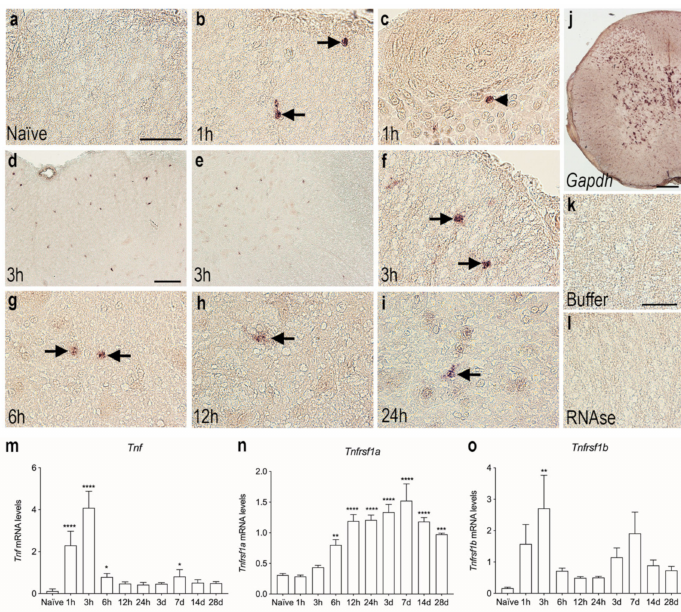
Figure 2. Cellular and temporal expression of Tnf mRNA in the thoracic spinal cord after SCI. ( a – i ) In situ hybridization was used to investigate the distribution of Tnf mRNA + cells the first 24 h after SCI. Tnf mRNA expression was undetectable in naïve mice ( a ). Tnf mRNA + cells in the white matter of the posterior funiculi (arrows in b ) and in neuronal-like cells in the dorsal horn (arrowhead in c ), at 1 h after SCI. Tnf mRNA + cells in the white matter of the posterior funiculi ( d ) and in the grey matter of the ventral horn ( e ). At 3 h, most cells displayed macrophage- or glial-like morphology (arrows in f ). By 6 h ( g ), 12 h ( h ), and 24 h ( i ), Tnf mRNA + cells were mainly located in white matter areas of the damaged spinal cord (arrows). ( j ) Parallel spinal cord sections that were in situ hybridized for glyceraldehyde-3-phosphate dehydrogenase ( Gapdh ) mRNA showed a largely neuronal signal and confirmed the overall suitability of the tissue for in situ hybridization. ( k , l ) Parallel sections hybridized with buffer alone ( k ) or pretreated with RNAse A before the in situ hybridization ( l ) were devoid of signal. ( m – o ) RT-qPCR analysis of Tnf mRNA ( m ) , Tnfrsf1a mRNA ( n ), and Tnfrsf1b mRNA ( o ) levels in naïve mice and in mice allowed 1, 3, 6, and 12 h and 1, 3, 7, 14, and 28-days survival after SCI. Tnf mRNA levels were significantly increased at 1, 3, and 6 h and 7 days after SCI, compared to naïve mice (Time: p < 0.0001, F 9,39 = 58.14) ( m ). Tnfrsf1a mRNA levels significantly increased from 6 h to 28 days after SCI, compared to naïve mice (Time: p < 0.0001, F 9,39 = 20.01) ( n ). Tnfrsf1b mRNA levels significantly increased at 3 h after SCI, compared to naïve mice (Time: p = 0.009, F 9,39 = 2.965). Results are expressed as mean ± SEM, n = 5/group, * p < 0.05, ** p < 0.01, *** p < 0.001, **** p < 0.0001. Scale bars: ( a – c , f – i , k , l ) = 40 µ m, ( d , e ) = 100 µ m, and ( j ) = 200 µ